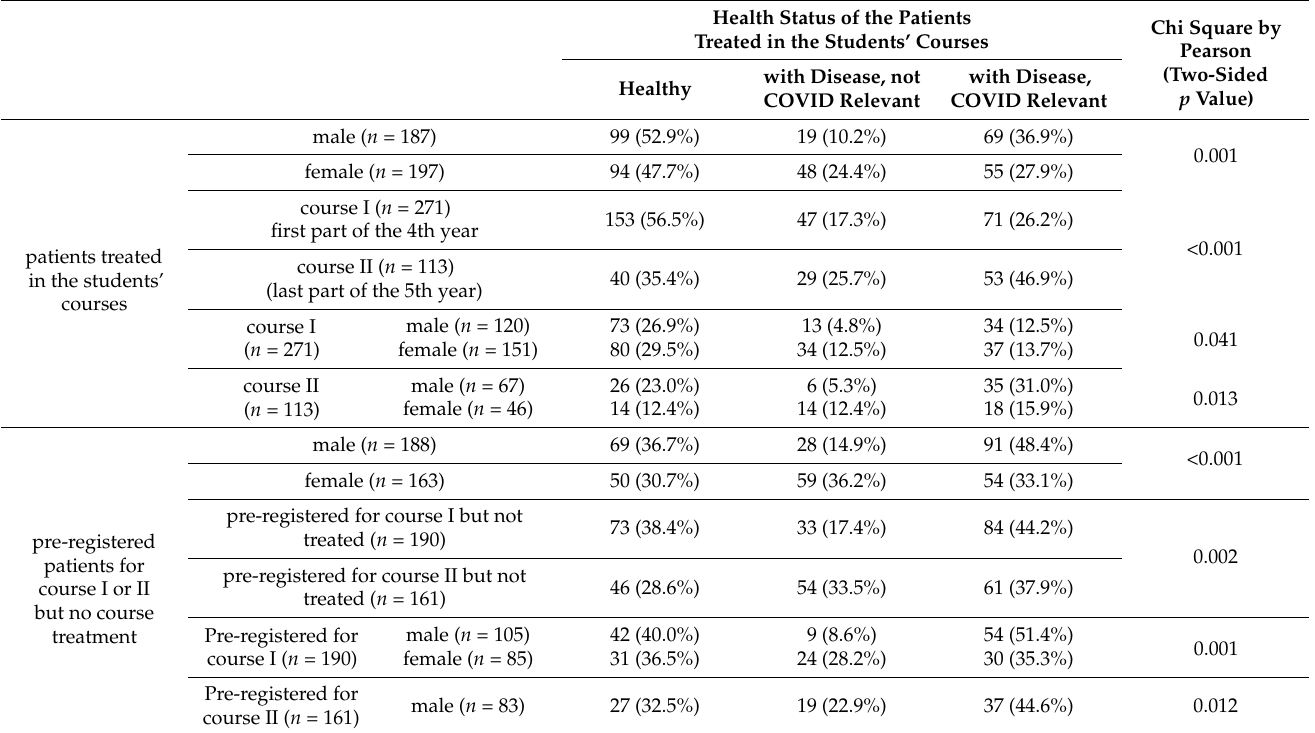
Table 3. Health status of the treated and pre-registered non-treated patients in the student course in relation to gender and course